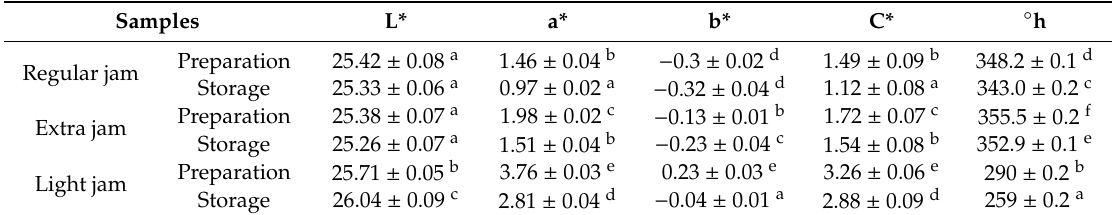
Table 5. Color parameters (L*, a*, b*, C* and ◦ h) of regular, extra and light tart cherry jams after preparation and after storage at room temperature for eight